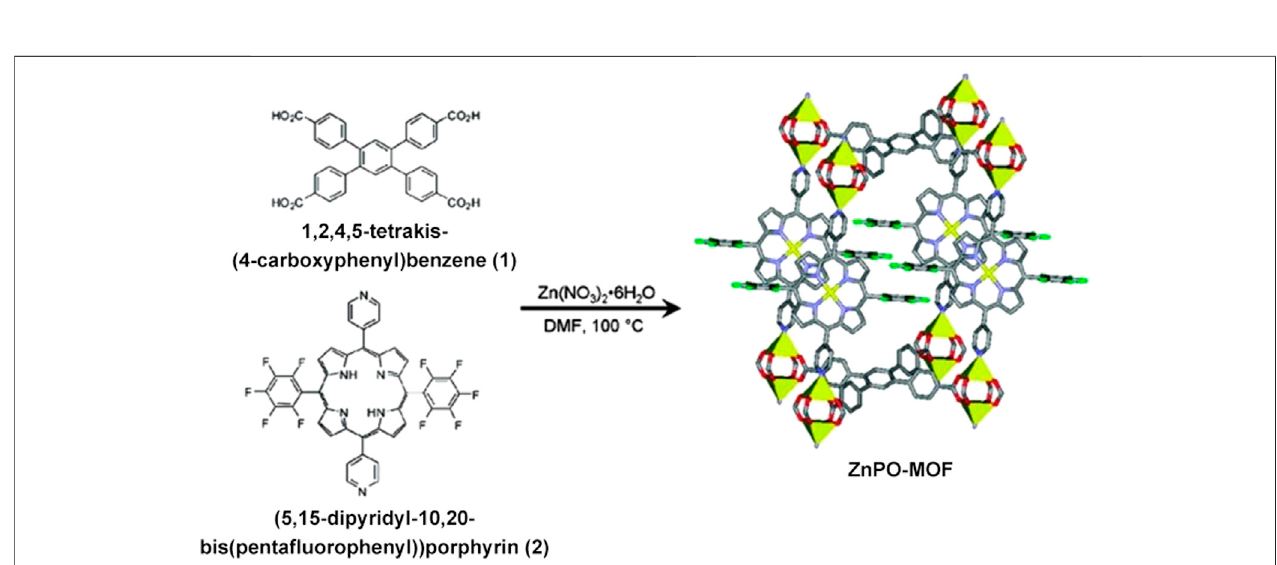
FIGURE 5 | The synthesis of ZnPO-MOF. The MOF (right) has multiple features for catalysis, such as large pores, permanent microporosity, and fully reactant- accessible active sites. Reproduced from Shultz et al. (2009) with permission. Copyright 2009 American Chemical Society.